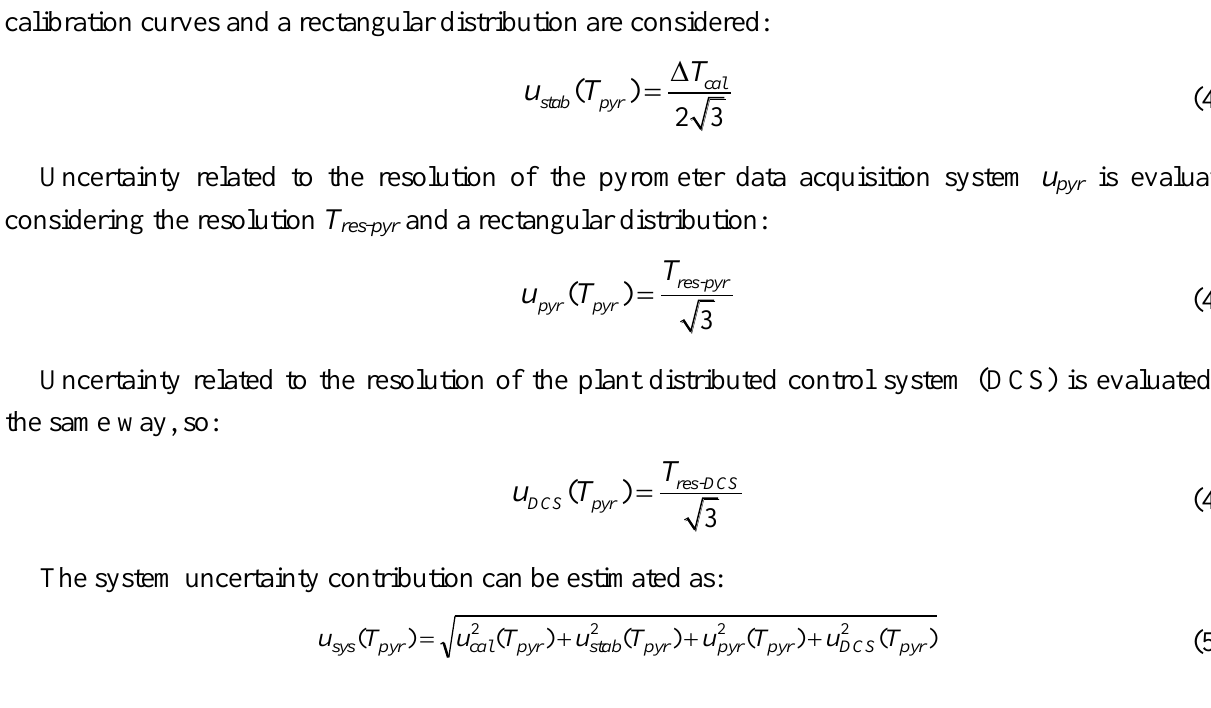
Table 2. Typical uncertainty budget for T